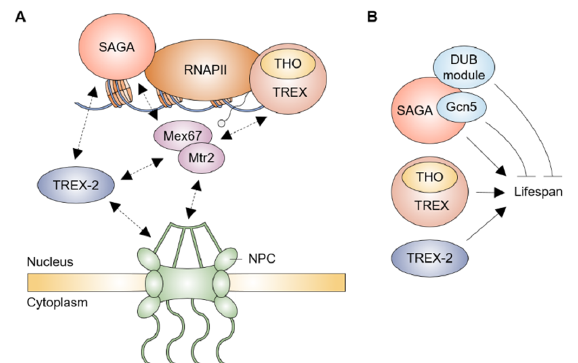
Figure 1. The conserved TREX and TREX-2 complexes. Both TREX and TREX-2 complexes are conserved between yeast and human. The TREX complex includes the multi-subunit THO complex and mRNA export proteins.